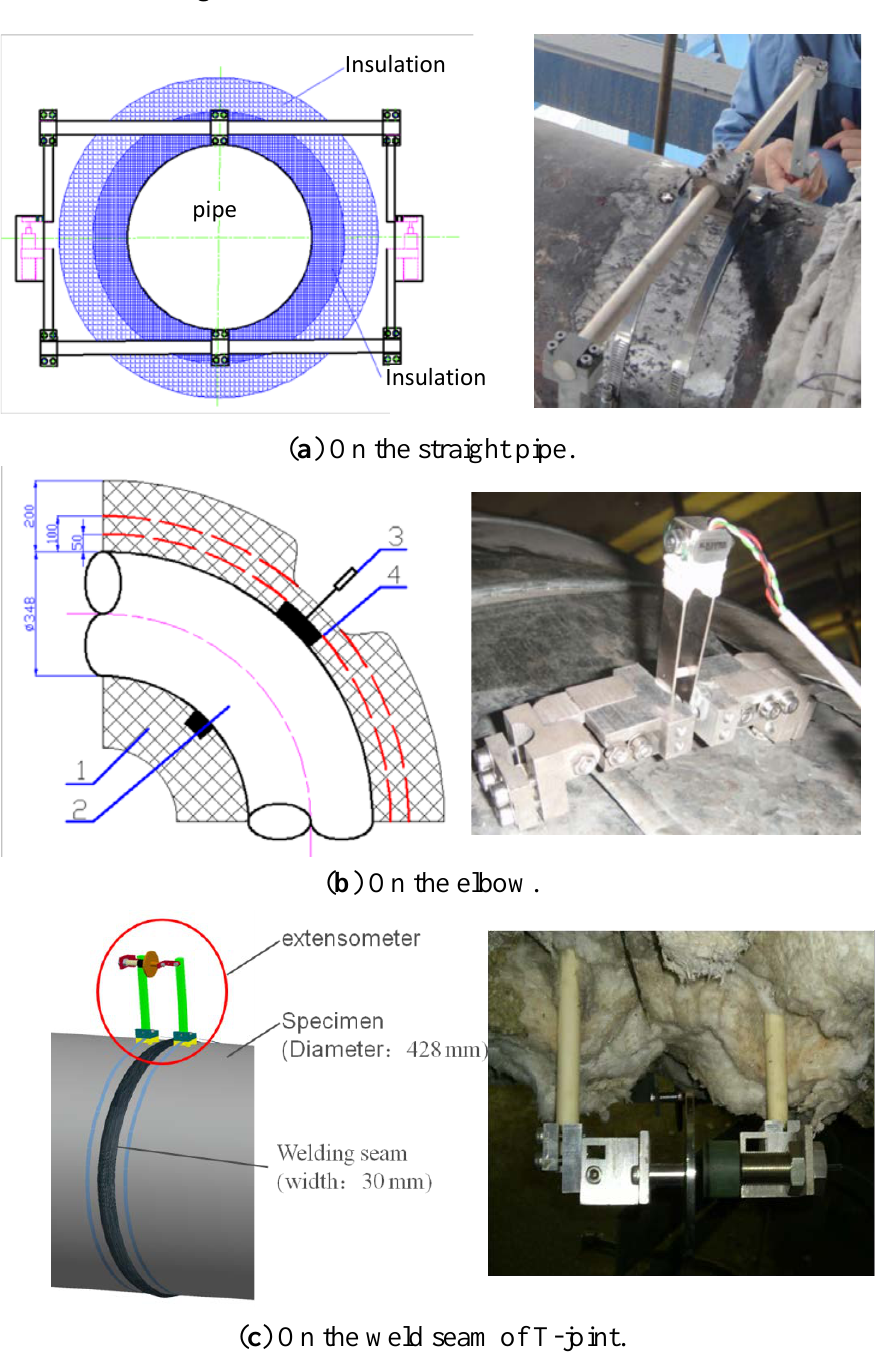
Figure 4. Installation of the